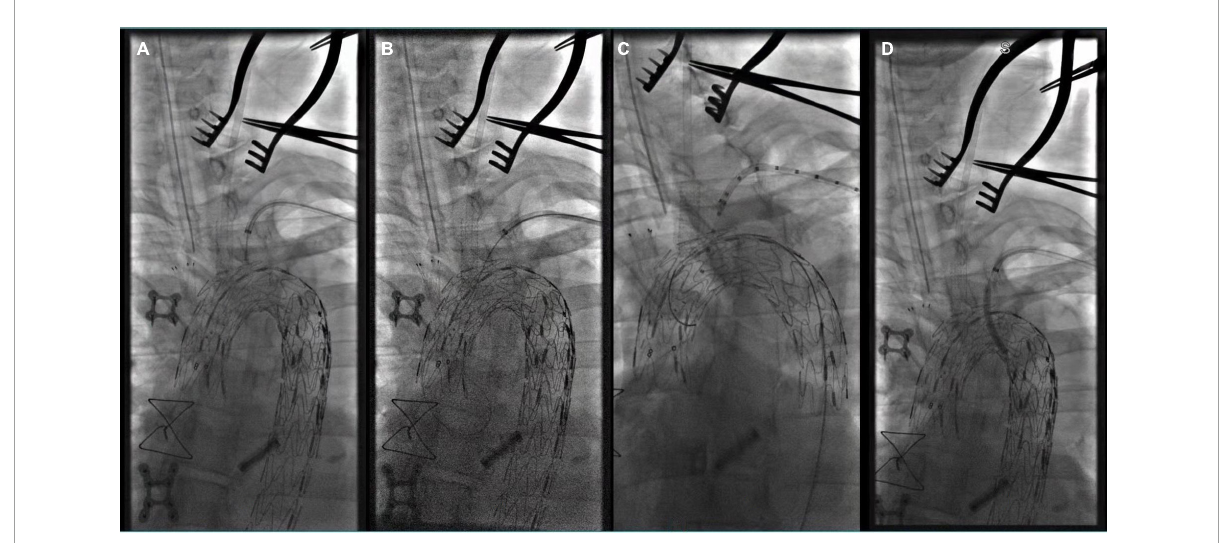
FIGURE4 (A) The tip of Fustar sheath was deflected and directly contact the fabric part of the main stent graft and in situ needle fenestration was applied; (B) 0.018 inch guidewire was punctured into the main stent; (C) A pigtail angiographic catheter was exchanged and advanced into the ascending aorta for angiography; (D) The fenestration was dilated by the balloon catheter after successful fenestration in the